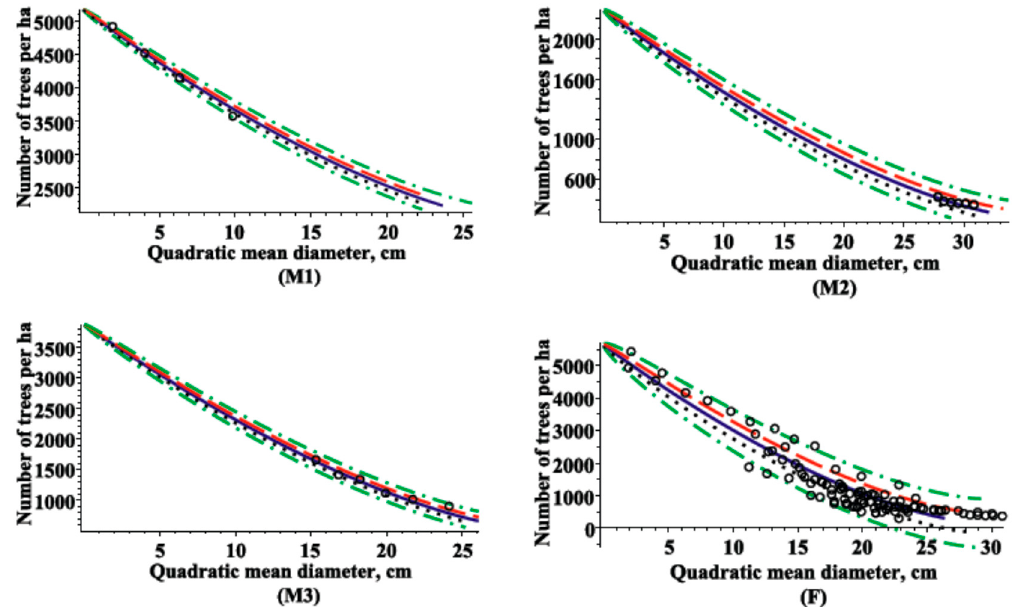
Figure 4. Relationships between the number of live trees per hectare (declining over age) and the quadratic mean diameter (increasing over age). ( M1 ) mixed effects scenario for the first stand; ( M2 ) mixed effects scenario for the second stand; ( M3 ) mixed effects scenario for the third stand; ( F ) fixed effects scenario for all stands; solid-blue line–the third 0.5-quantile scenario; dash-red line–the second 0.75-quantile scenario; dot-black line–the first 0.25-quantile scenario; dashdot-green line–the 0.05-and 0.95-quantile scenarios; circle–observed values.